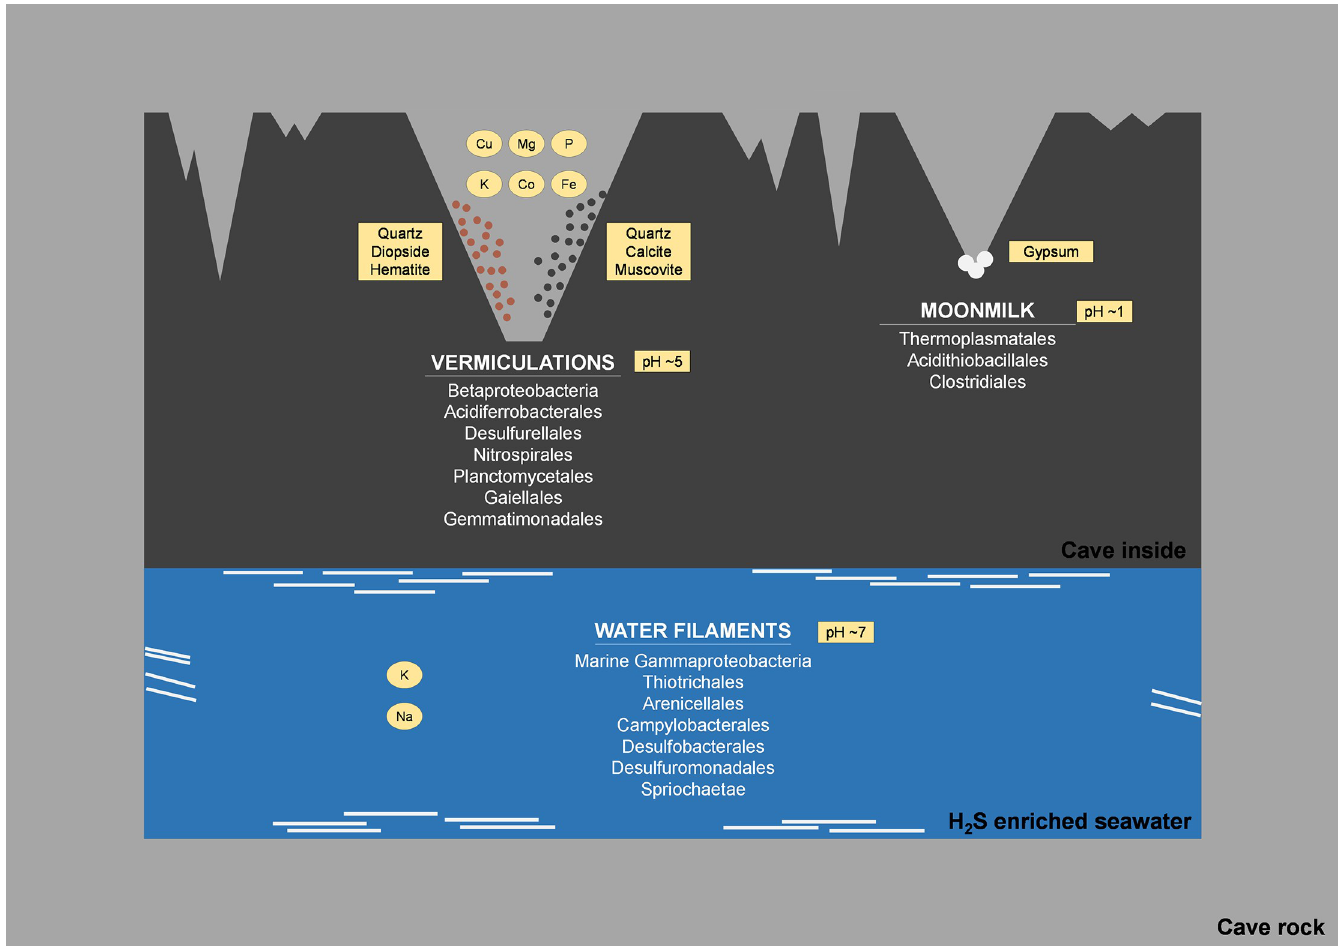
Fig 14. Schematic representation of the distribution pattern of water filaments, (bio)vermiculations and gypsum moonmilk in Fetida Cave, along with the most representative microbial groups (in white) and the main geochemical (within squares) and mineralogical (within ovals) characteristics in each type of biofilm/ deposit. The pH values are also reported. For the water filaments, the three filament morphologies are shown, i.e. floating, sedimented, and streamer filaments.